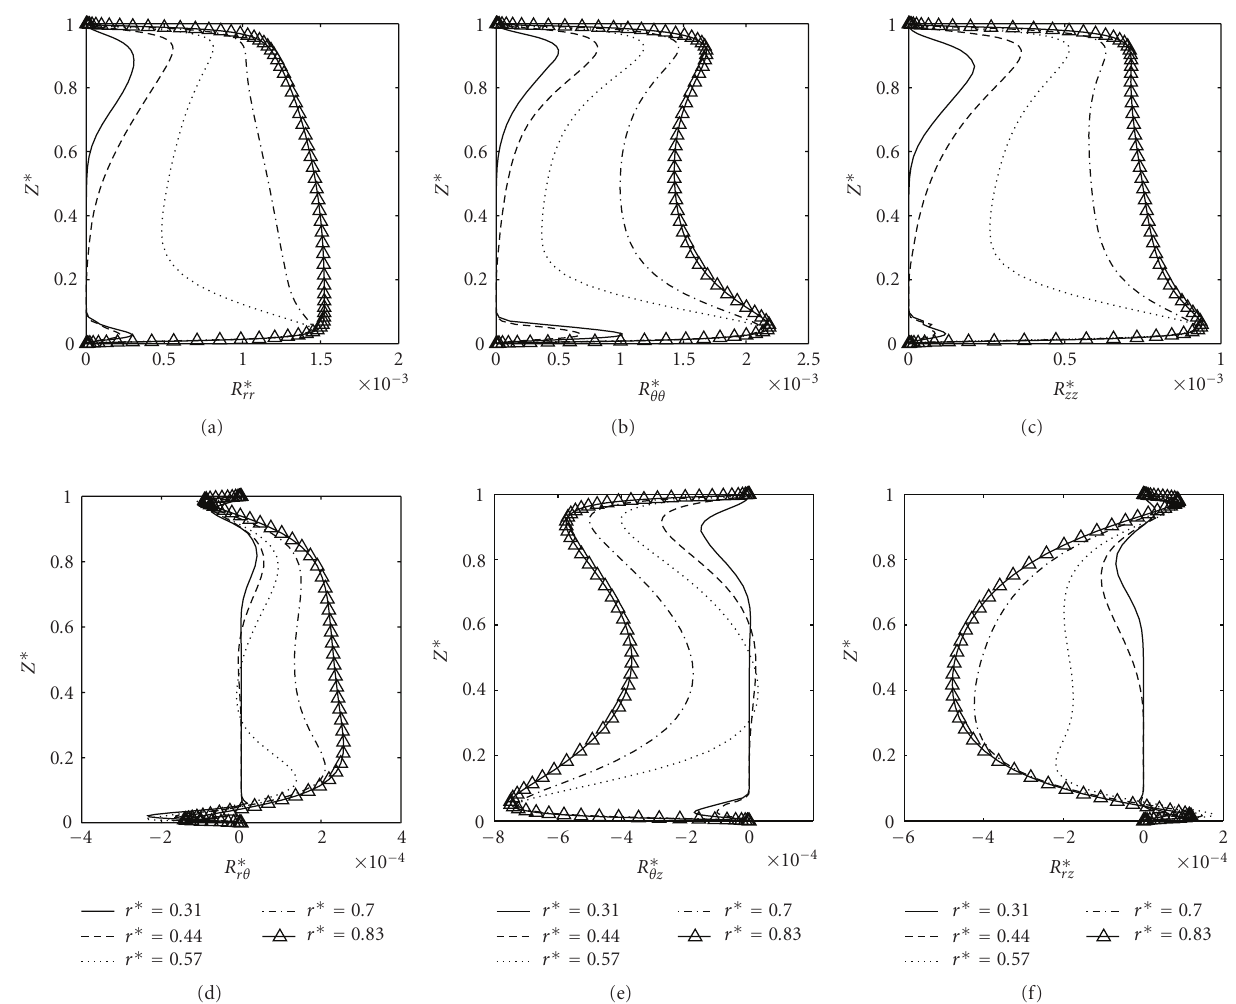
Figure 10: Axial profiles of the six Reynolds stress tensor components for Re = 10 6 and G = 0 . 02 at di ff erent radial locations r ∗ .